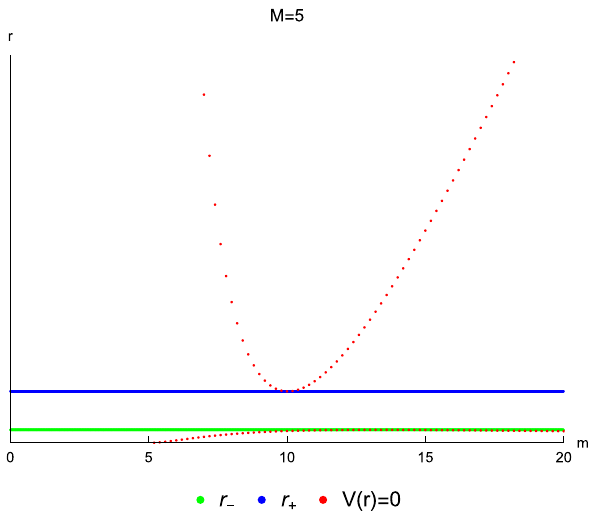
Fig. 1 For M = 5, the solutions of the equation V ( r ) = 0 are plotted over the range m = 5 to m = 20, with the intervals (cid:16) m = 0 . 2. Note thatthedistancebetweenhorizons hasbeenscaledown tomakeiteasier to display turning points